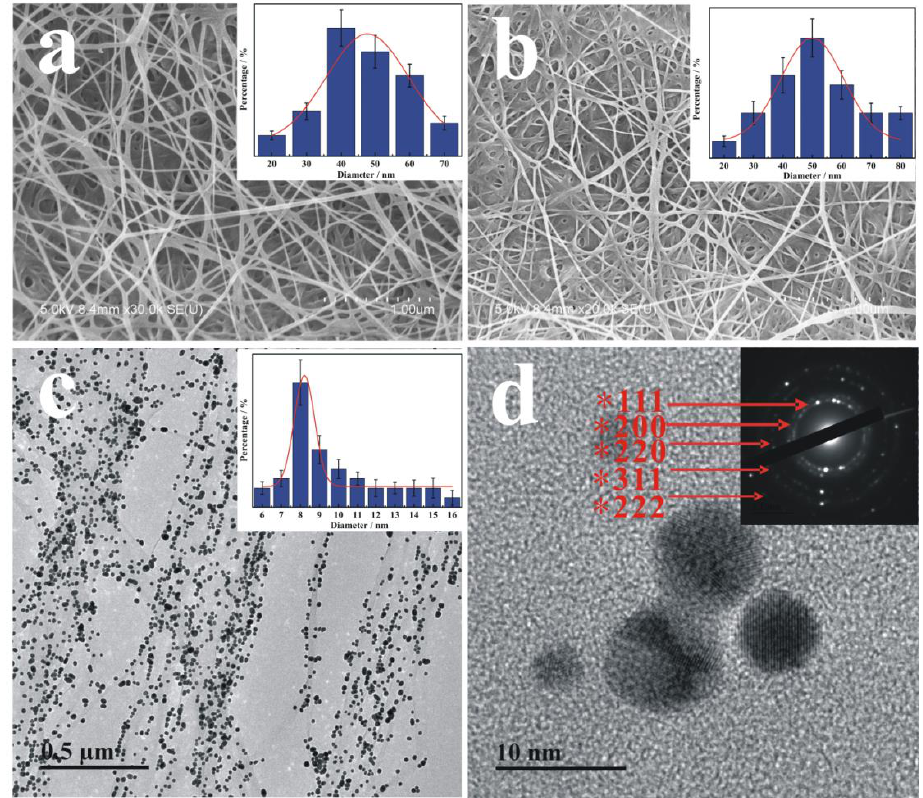
Figure 3. Scanning electron microscope (SEM) images of ( a ) BC and ( b ) BC-poly(HEMA) with the grafting rate of 21.7 wt% (inset image is a diameter of fibers of these materials in the case of BC-and BC-poly(HEMA)); transmission electron microscope (TEM) images of ( c ) AuNPs/BC-poly(HEMA), ( d ) as-synthesized AuNPs (enlarged), with the top right of inset presented selected area electron diffraction (SAED) pattern of AuNPs (high-resolution TEM (HR-TEM)).